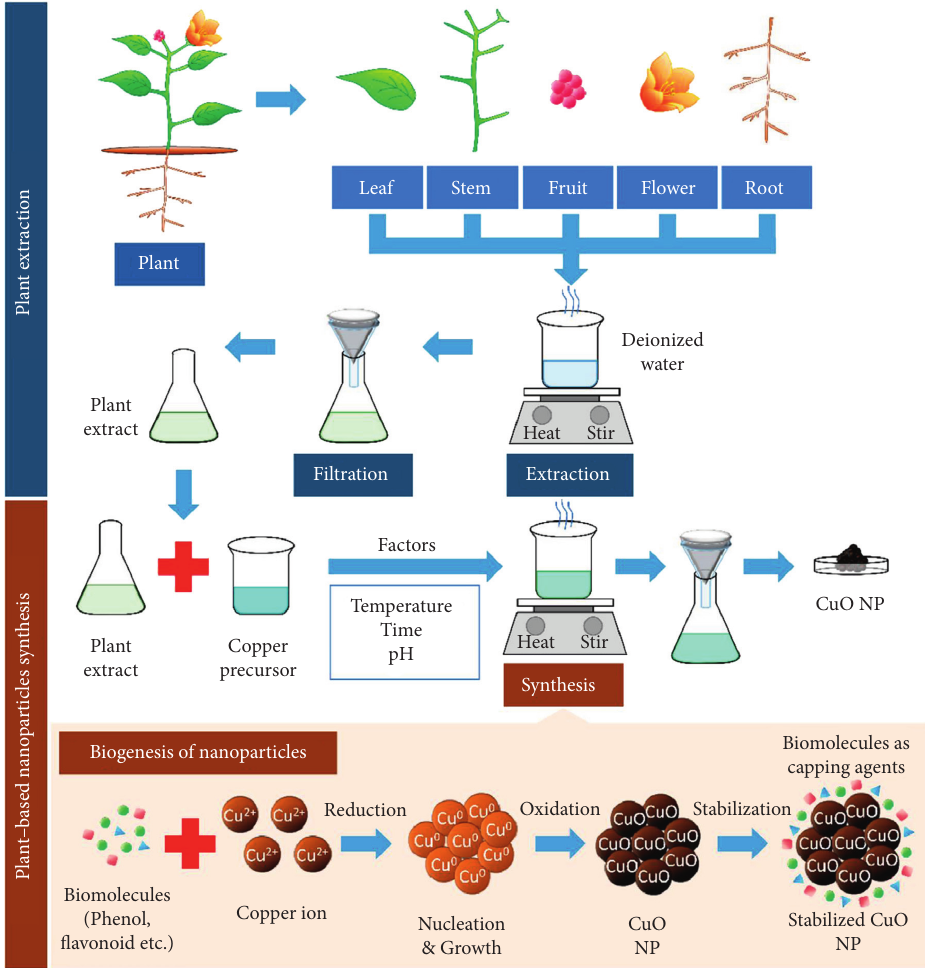
Figure 9: Plant-based green synthesis of copper oxide nanoparticles